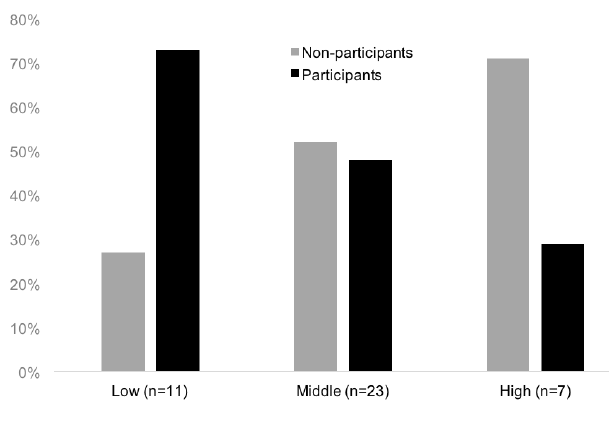
Fig. 1. Levels of economic well-being and logging project participation in Chico Mendes Extractive Reserve. An inverse relationship between economic well-being and logging